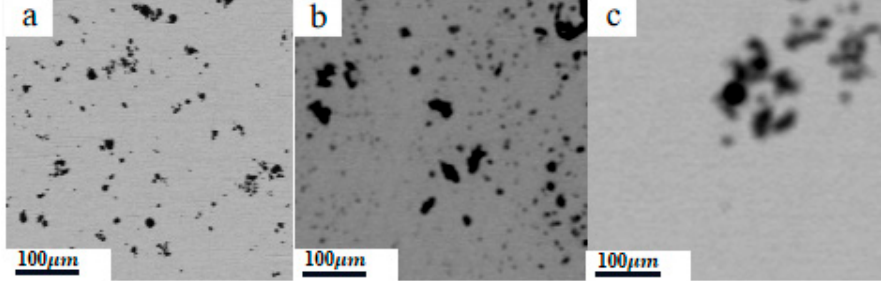
Figure 9. The backscatter image of the specimens at different scanning speeds. ( a ) C80, ( b ) C100, ( c ) C120.